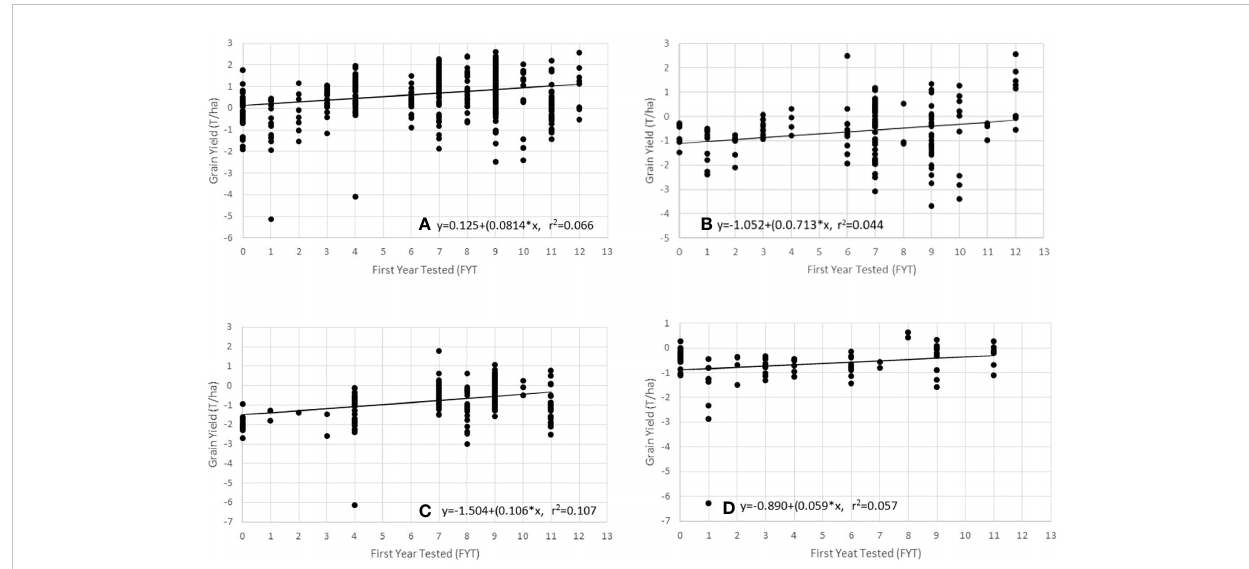
FIGURE 1 Regression of grain yield (GY) on to the First Year of Testing (FYT) using data from the Ugandan NPT trials. (A) all entries, (B) entries from private sector, (C) entries from CIMMYT sources, and (D) entries from